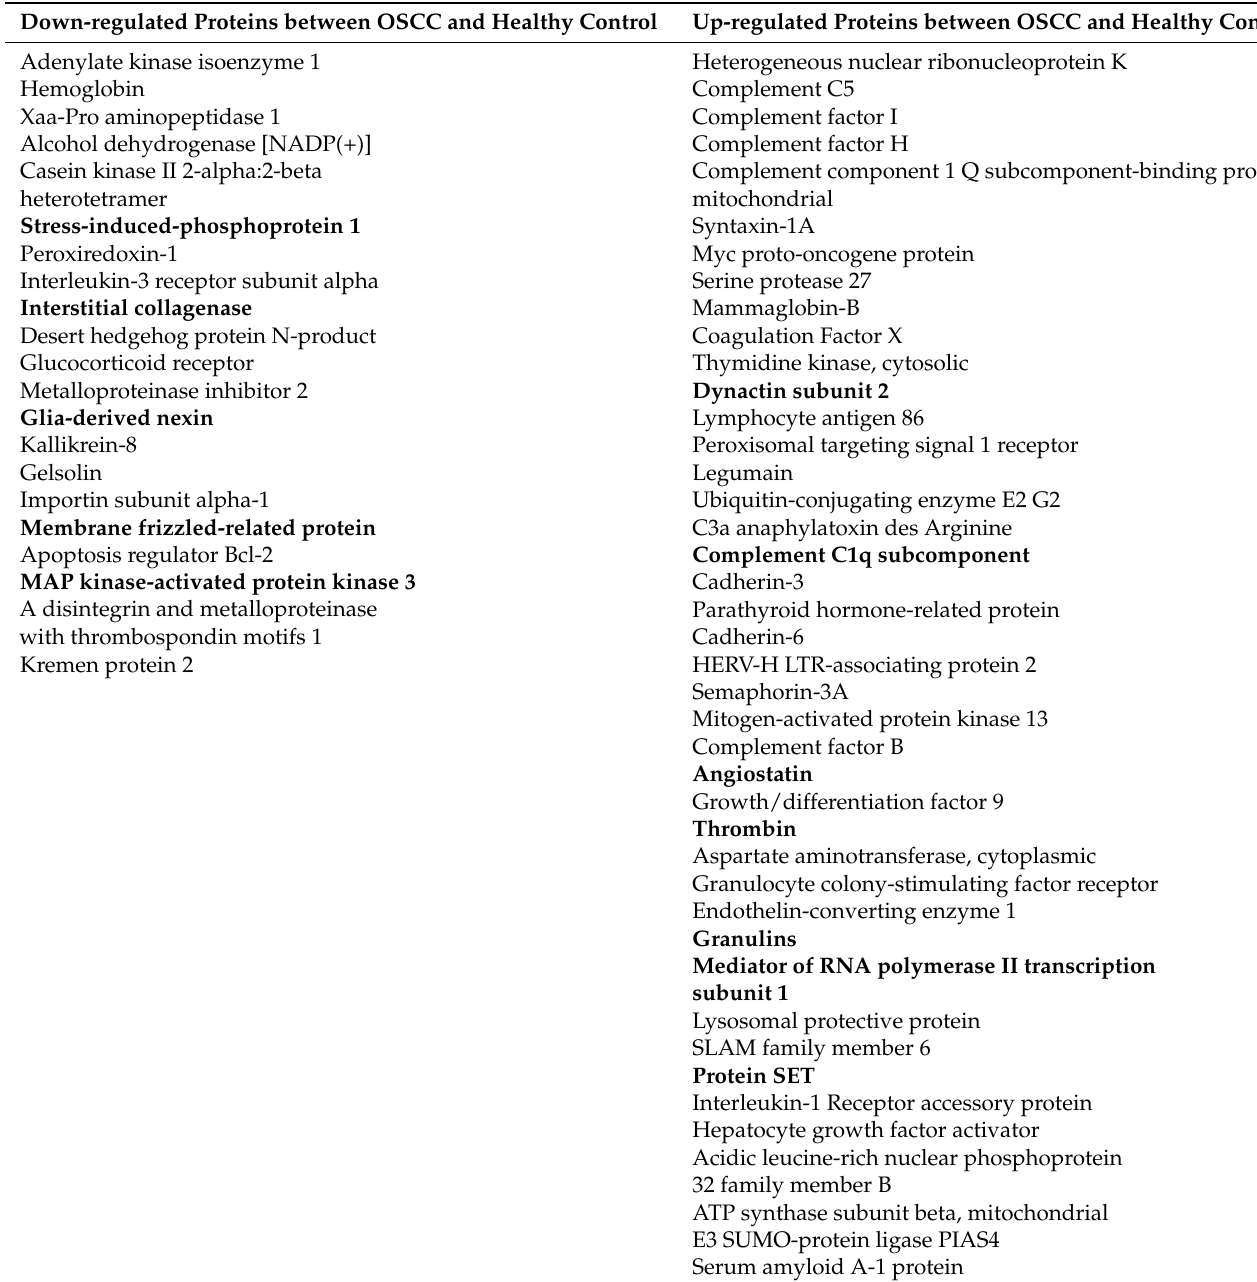
Table 2. Top Up-Regulated and Down-Regulated Proteins Between OSCC Cases and Healthy